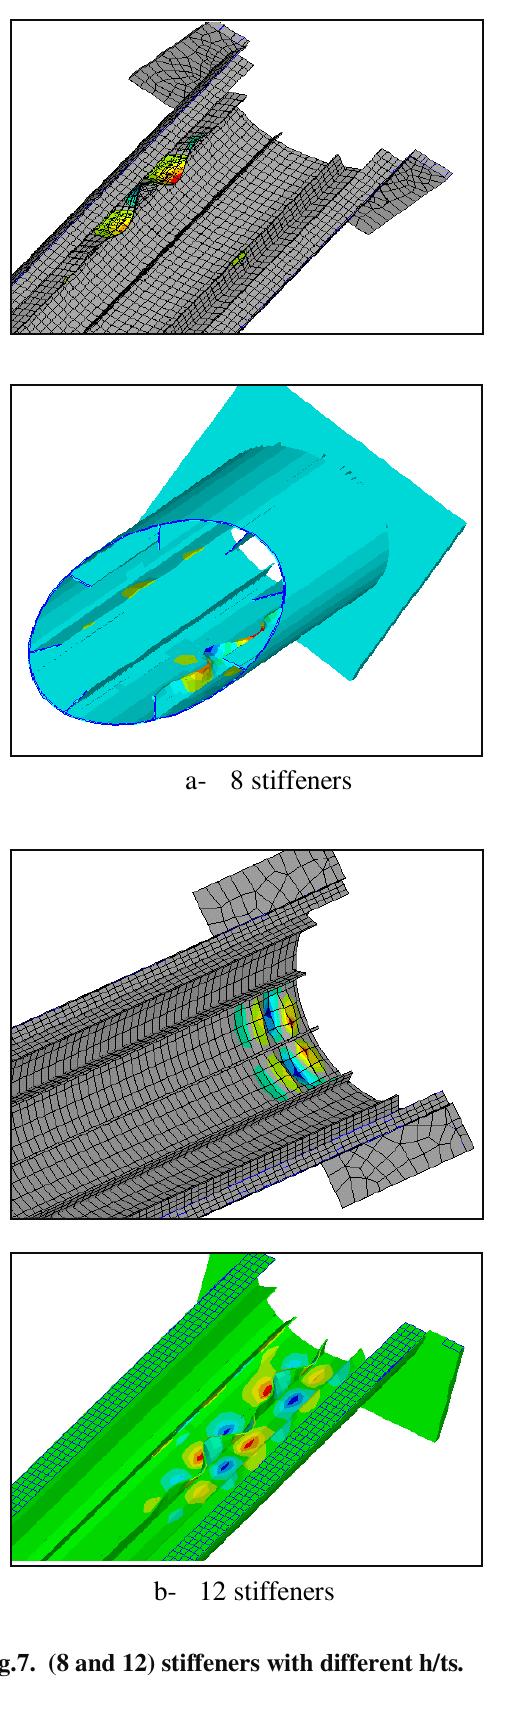
Fig.7. (8 and 12) stiffeners with different